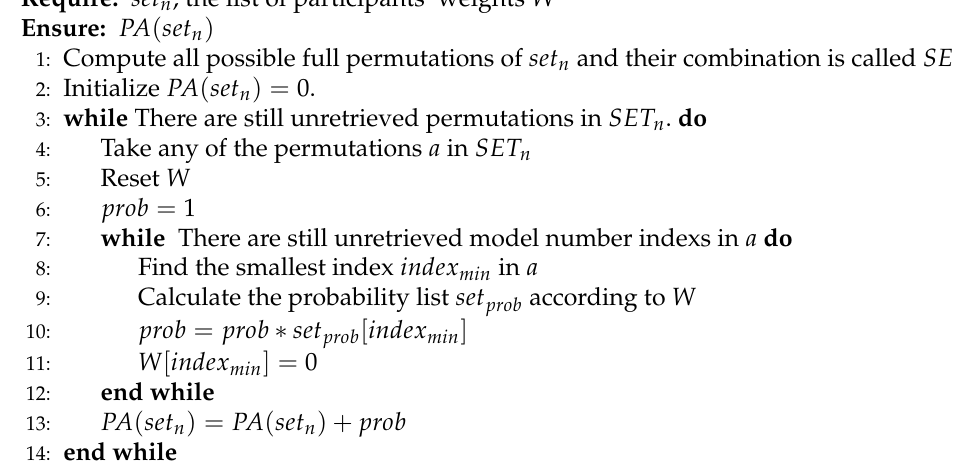
Algorithm 2 Solution for the probability of the combination set n of all candidate shadow models with obtaining valid